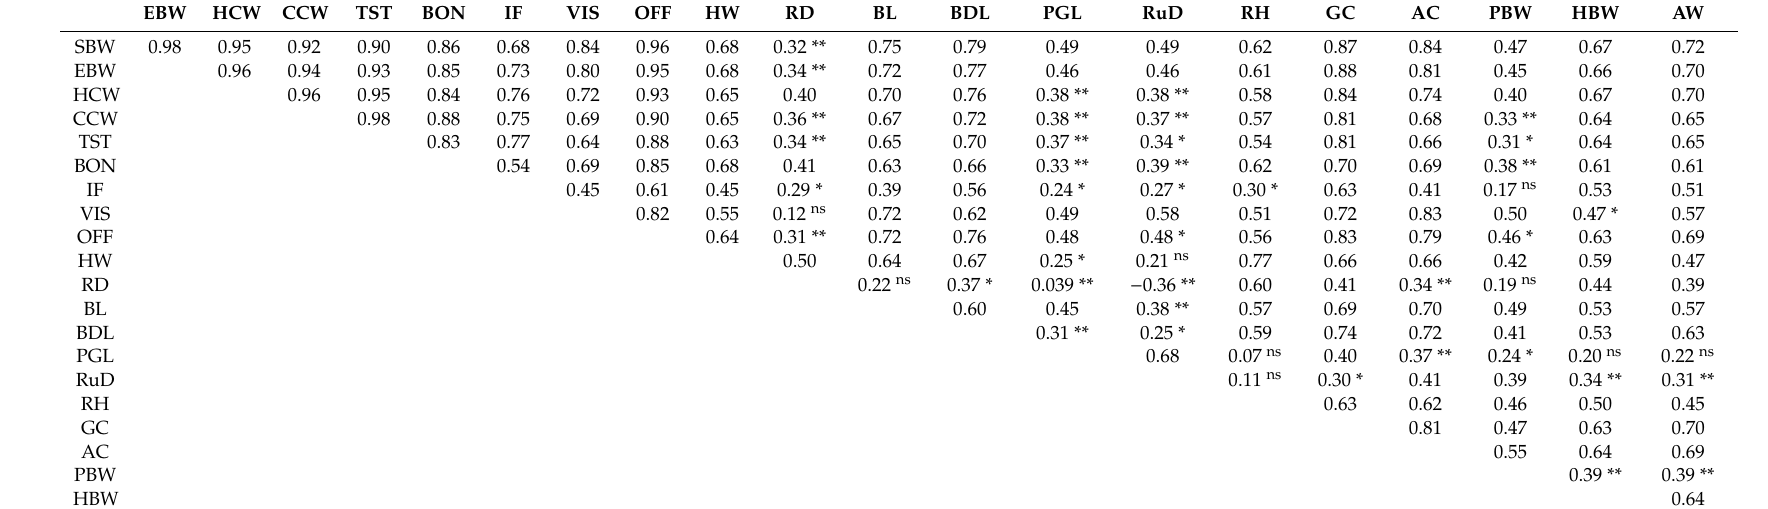
Table 2. Pearson correlations coe ffi cients of between body measurements and carcass traits of suckling hair lambs 1